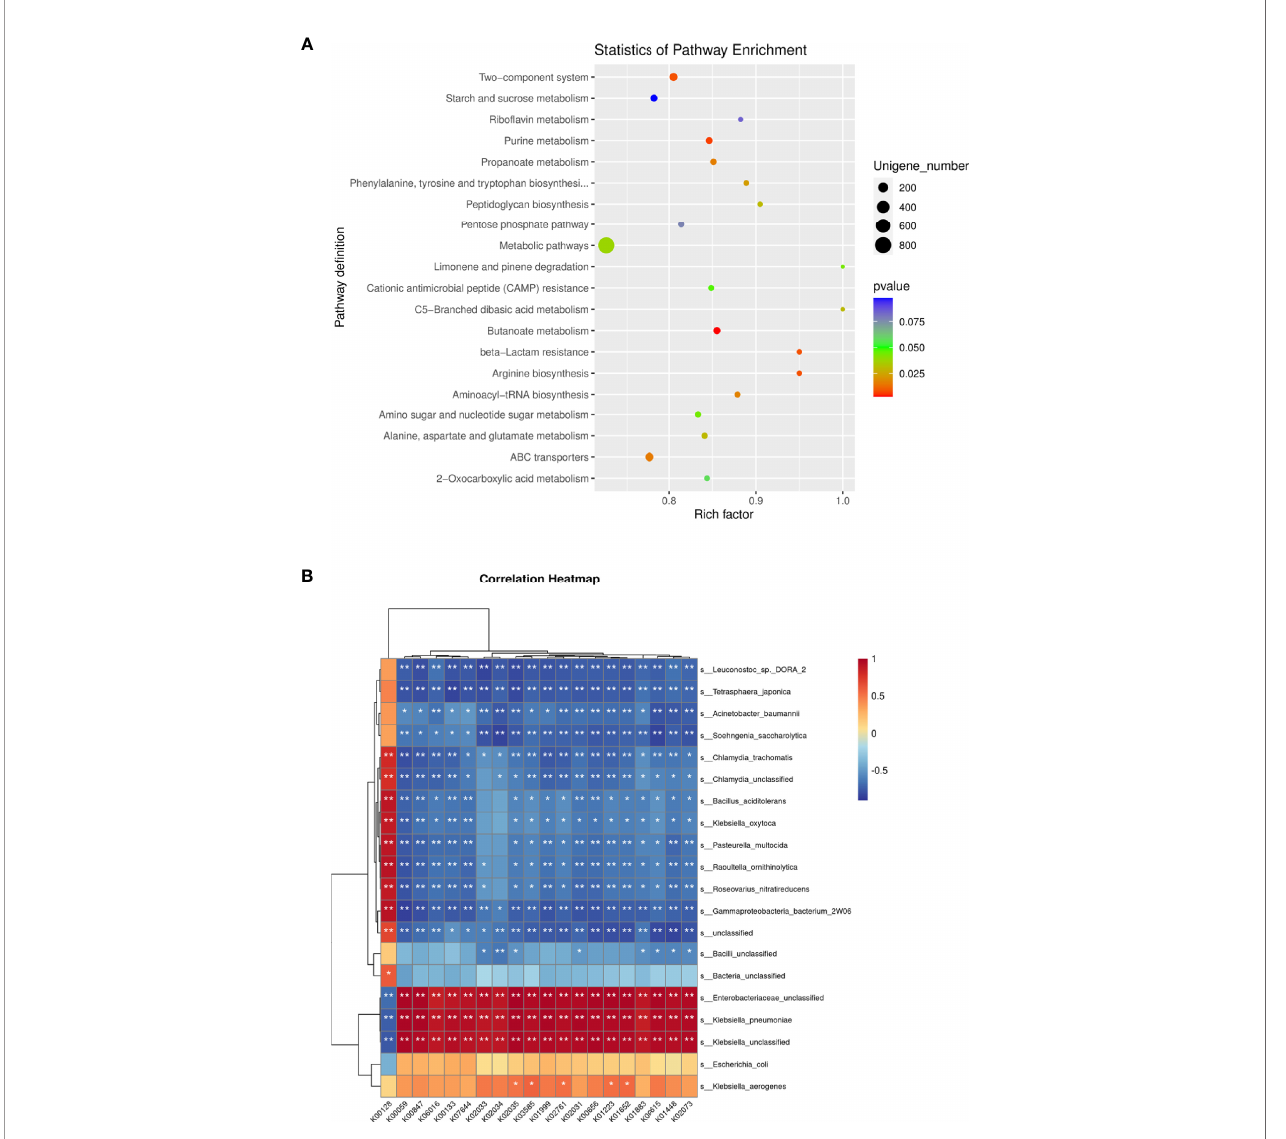
FIGURE 5 | Functional Characteristics of the Microbiota. Fifteen statistically signi fi cant pathways were enriched in the IKPLA group. (A) Among these pathways, the metabolic pathways represented most of the enriched genes. (B) The correlation between the top 20 species and the top 20 KOs was illustrated using clustering correlation heatmap. Positive and negative correlations are shown as red and blue in the heat map, respectively. ∗ Indicates p < 0.05, ∗∗ Indicates p <